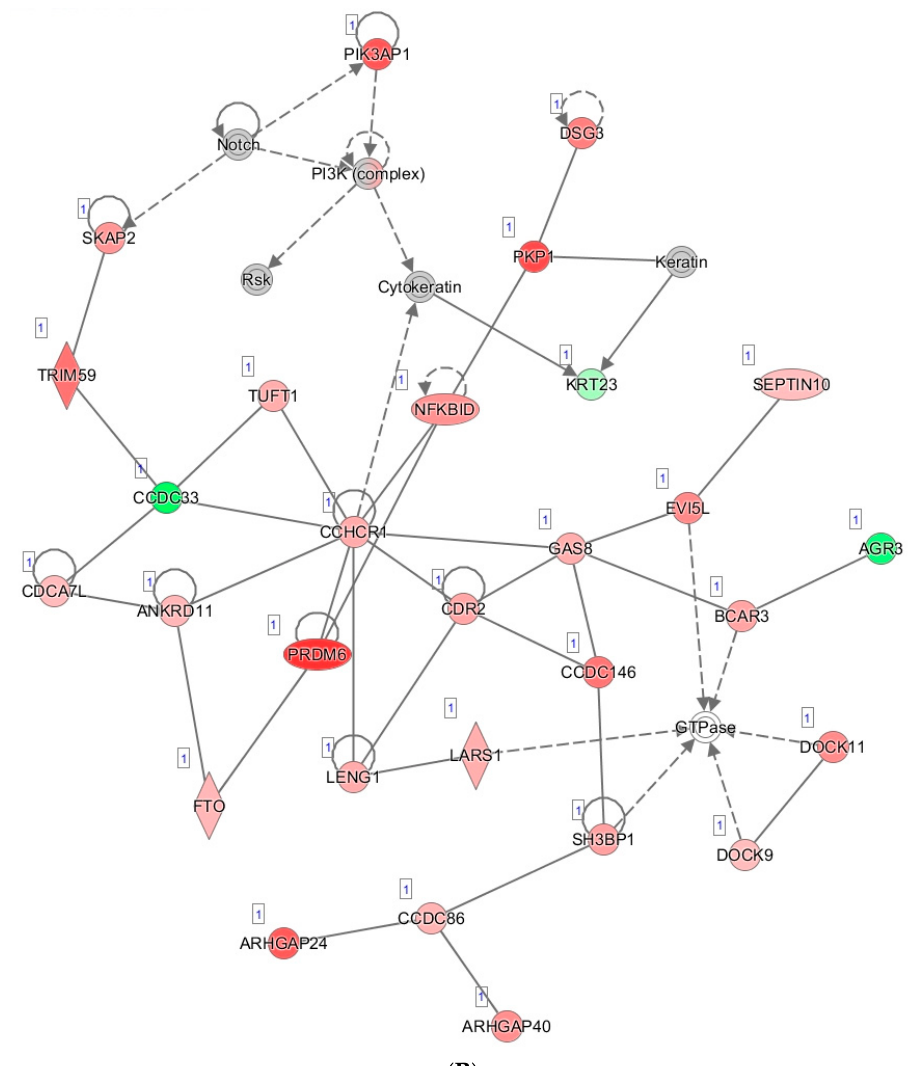
Figure 8. Network analysis of genes differentially expressed between carboplatin-resistant and carboplatin-sensitive TOs. Network mapping by Qiagen IPA with Global Network Overlay demonstrates the most significant gene network ( A ) and second most significant gene network ( B ).